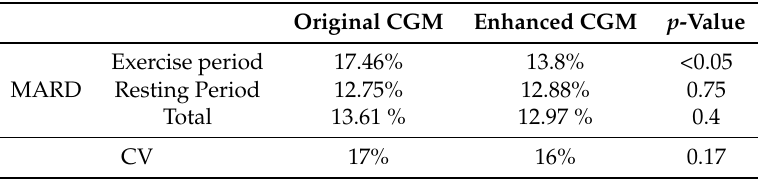
Table 4. MARD and CV results for the selected model.